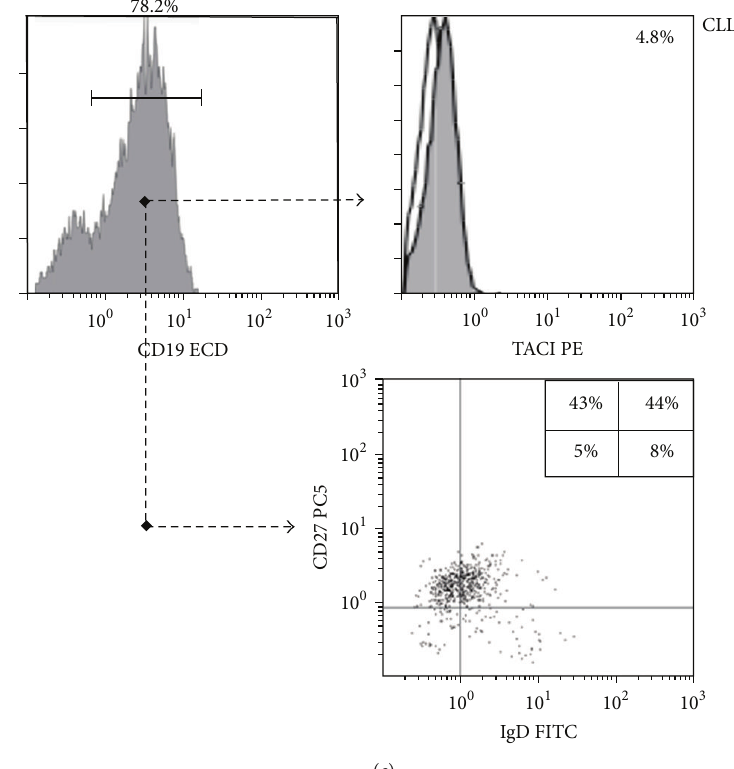
Figure 1: TACI along with CD27 and IgD expression on B cells established by flow cytometry in a healthy individual and 2 patients with CLL. TACI is expressed only on normal switched and nonswitched memory B cells (CD27 + IgD − and CD27 + IgD + , resp.) (a). CLL cells were CD27 + and the majority of them also IgD + , with high (b) and low (c) TACI expression.